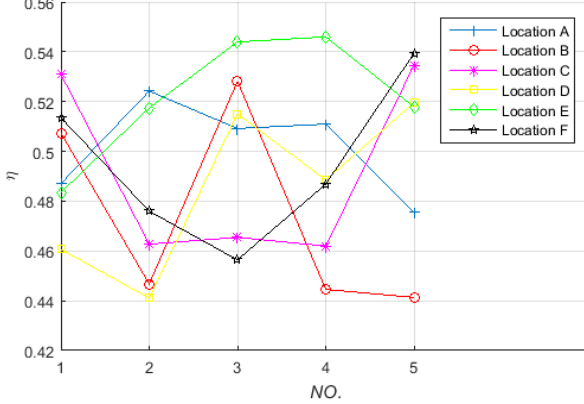
Figure 9. The power transfer efficiency versus the receiving coil with different locations and postures on the green spherical surface (radius is 0.4 m).